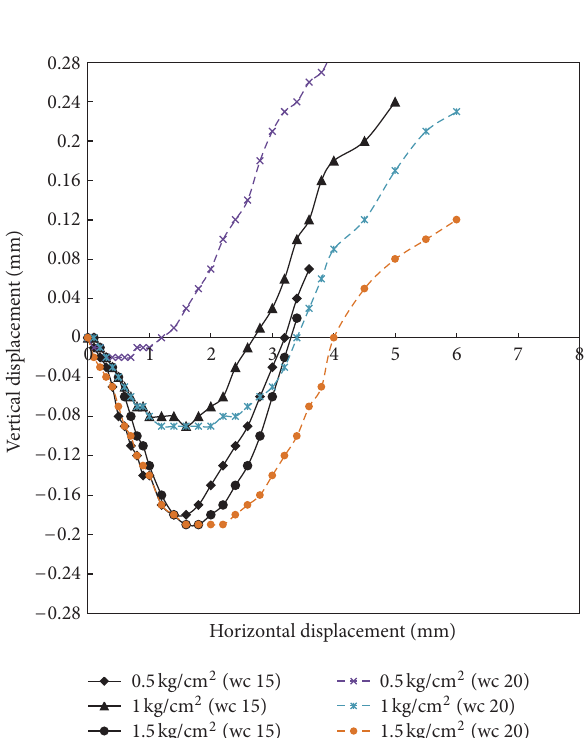
clay) for the normal stress of 0.5 kg/cm and positive for normal stresses of 1.0 and 1.5